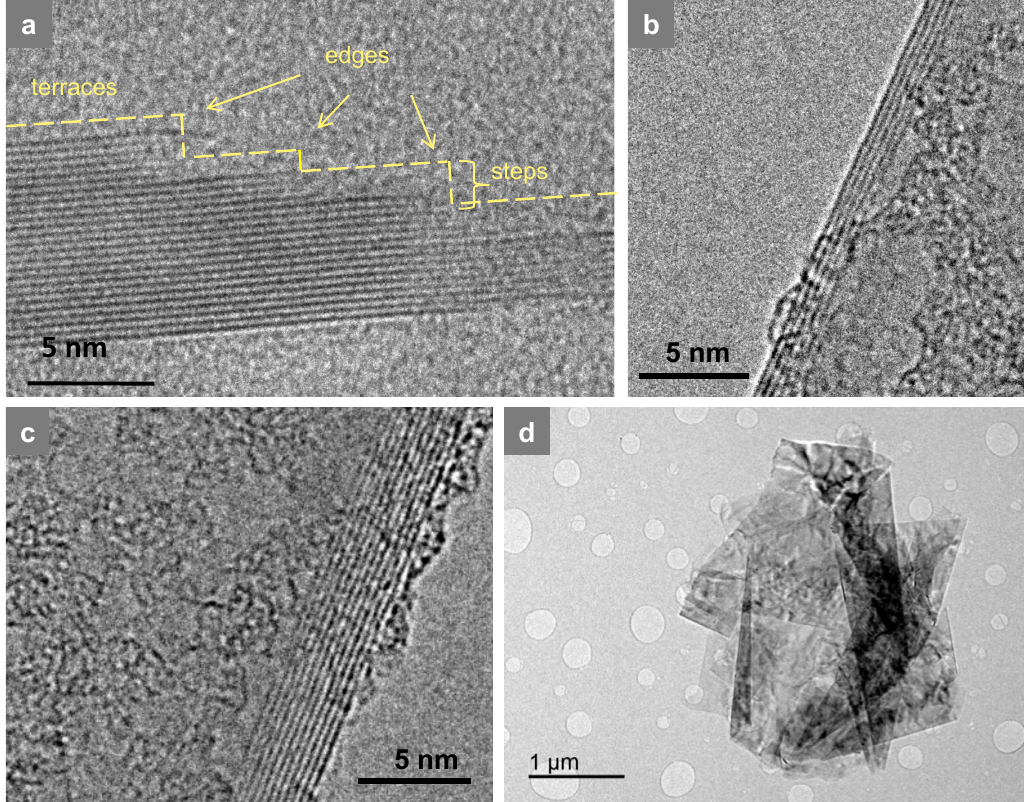
Figure 2. Transmission electron microscopy (TEM) micrographs of ( a ) a thicker flake of lead-FLG with multi-step structure, ( b and c ) variable number of sheets in graphite-FLG from the supernatant and settled-down part, respectively, and ( d ) overall view of the assembly of graphite-FLG flakes.